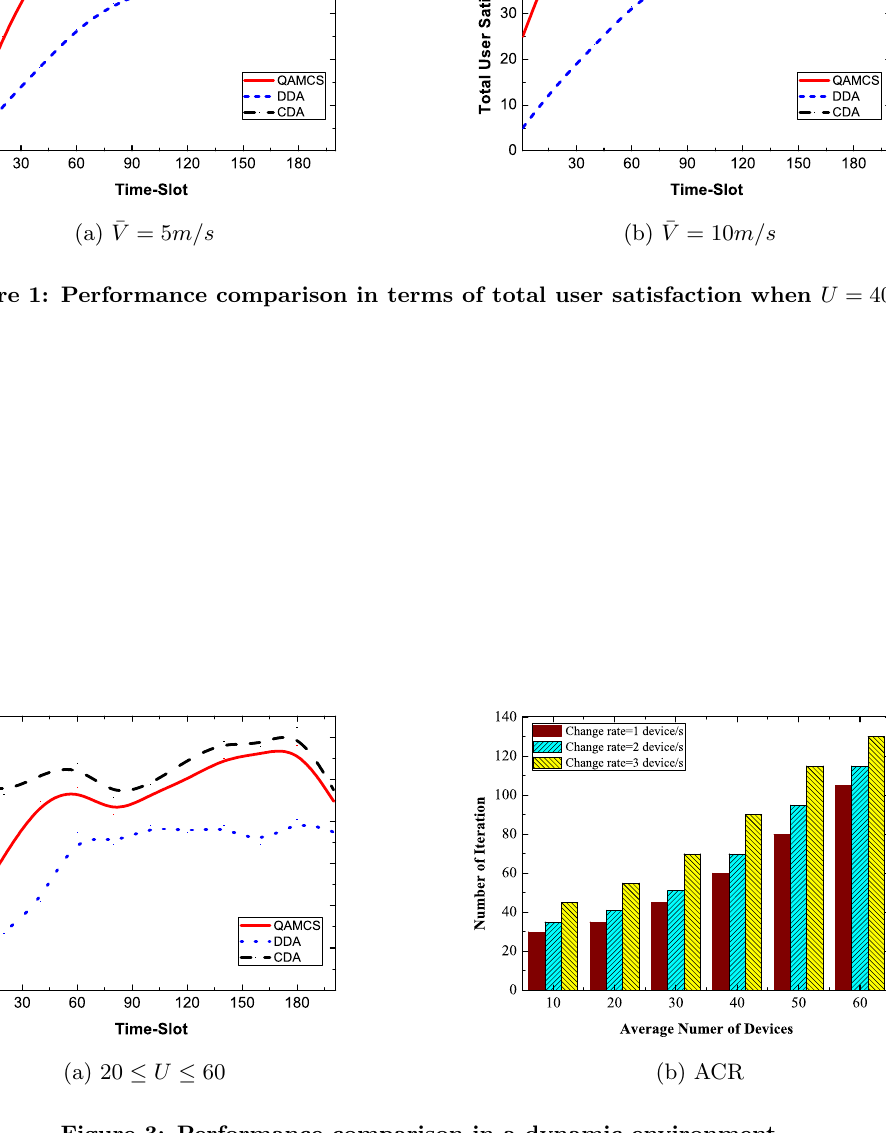
Figure 3: Performance comparison in a dynamic